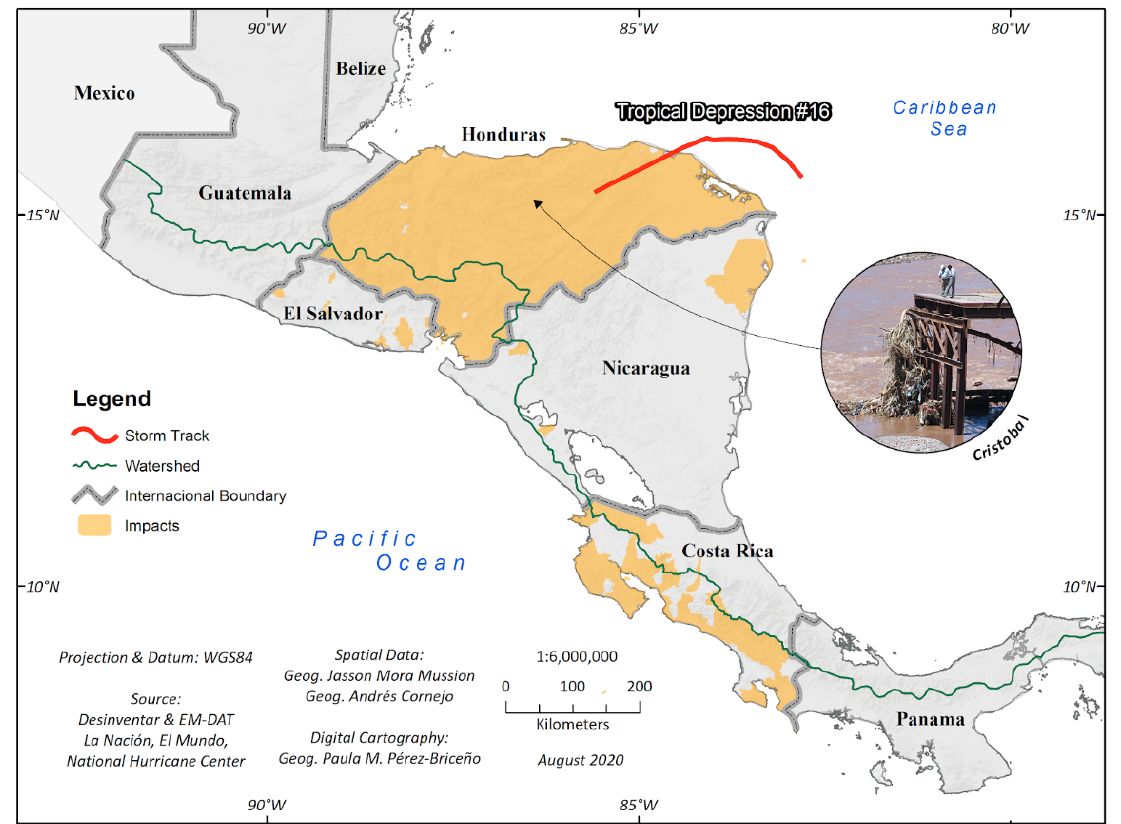
Figure A1. Examples of tropical cyclones in the Caribbean that caused widespread direct and indirect